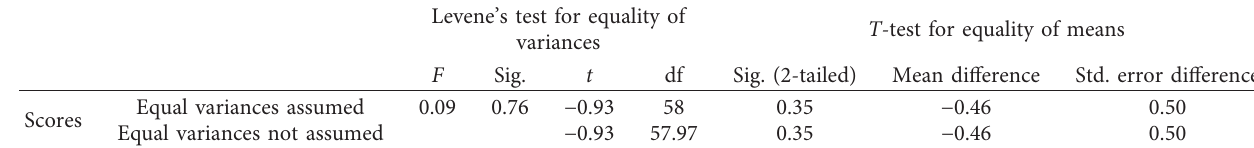
Table 2: Inferential statistics of the reading pretests.